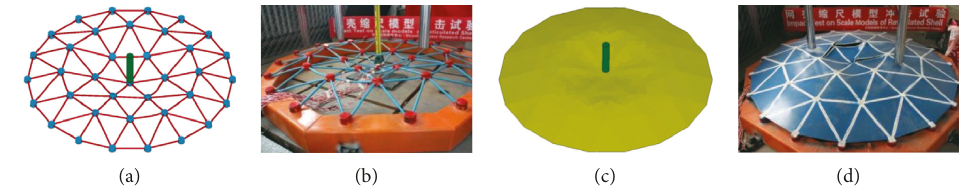
Figure 6: Comparison of the failure model of the reticulated dome. Without roof sheathing: (a) numerical results and (b) test results. With roof sheathing: (c) numerical results and (d) test results. Table 4: Impact mode and velocity of aircraft.